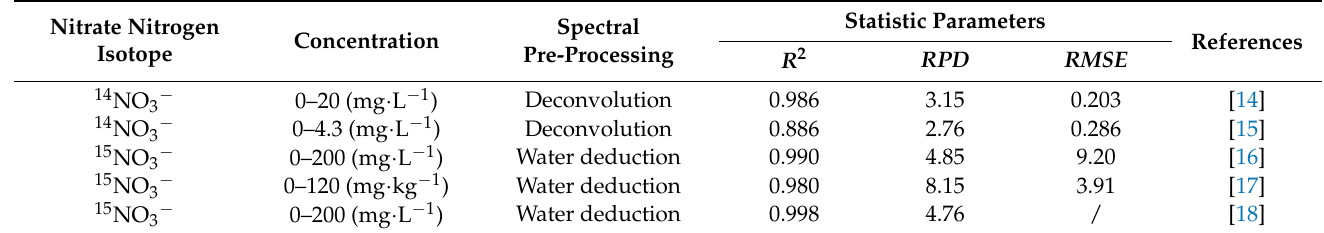
Table 3. Nitrate nitrogen isotope determination based on the PLSR model using FTIR-ATR spec-